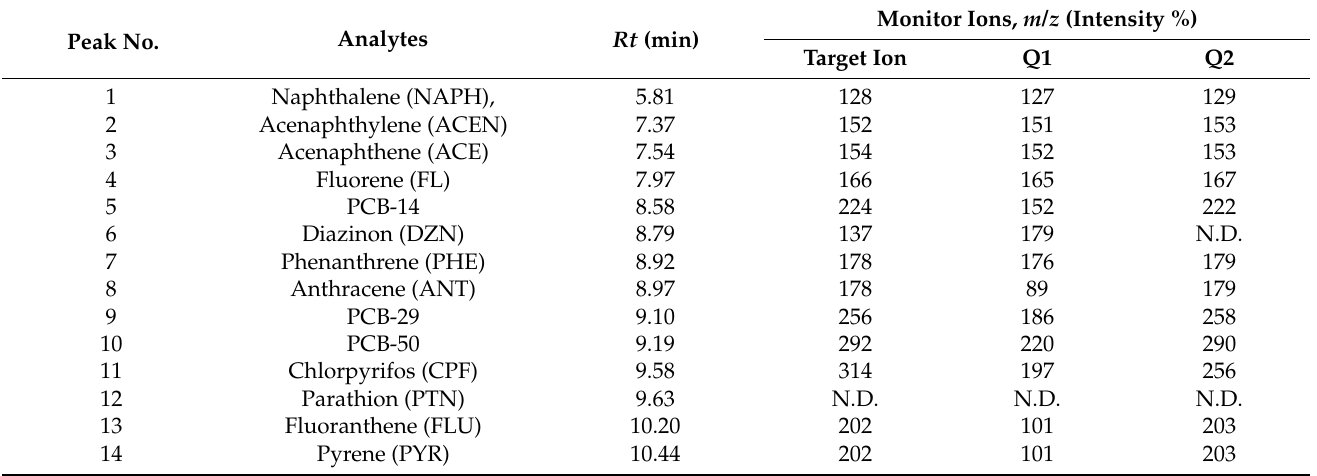
Table 1. GC–MS SIM mode for identification and quantitation of analytes. N.D., Not detected using SPMDs in SIM mode